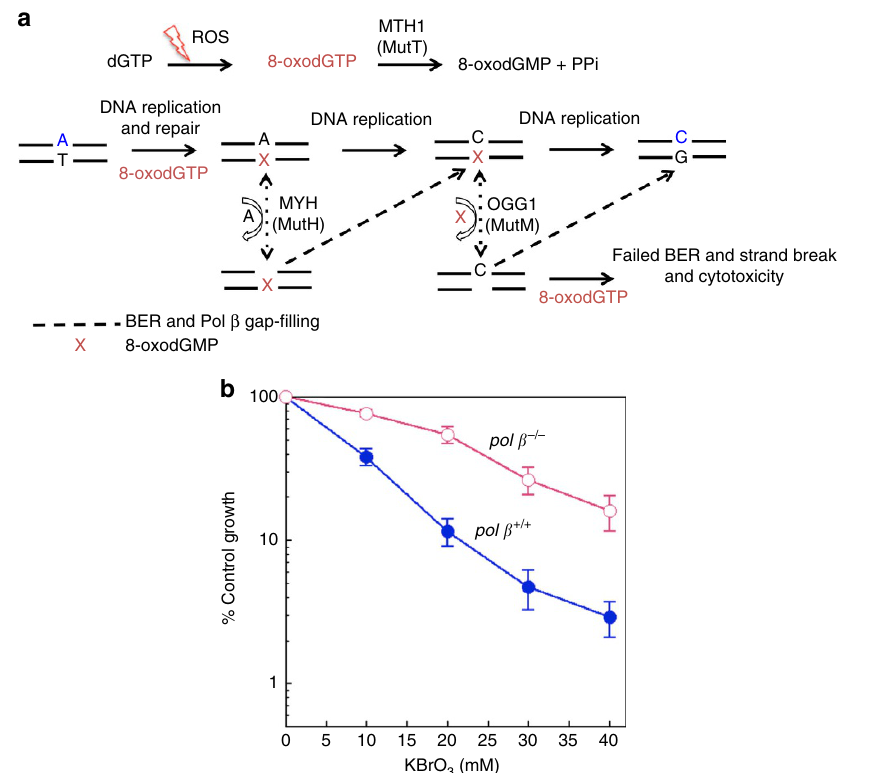
Figure 2 | Role of pol b in cellular responses to oxidative stress. ( a ) Illustration of pol b -mediated insertion of 8-oxoGTP upon 8-oxodGTPase deficiency. ( b ) Plots show pol b þ / þ and pol b (cid:2) / (cid:2) cells treated with a range of concentration of KBrO 3 (1h). The data represent mean values with the s.d. from five independent